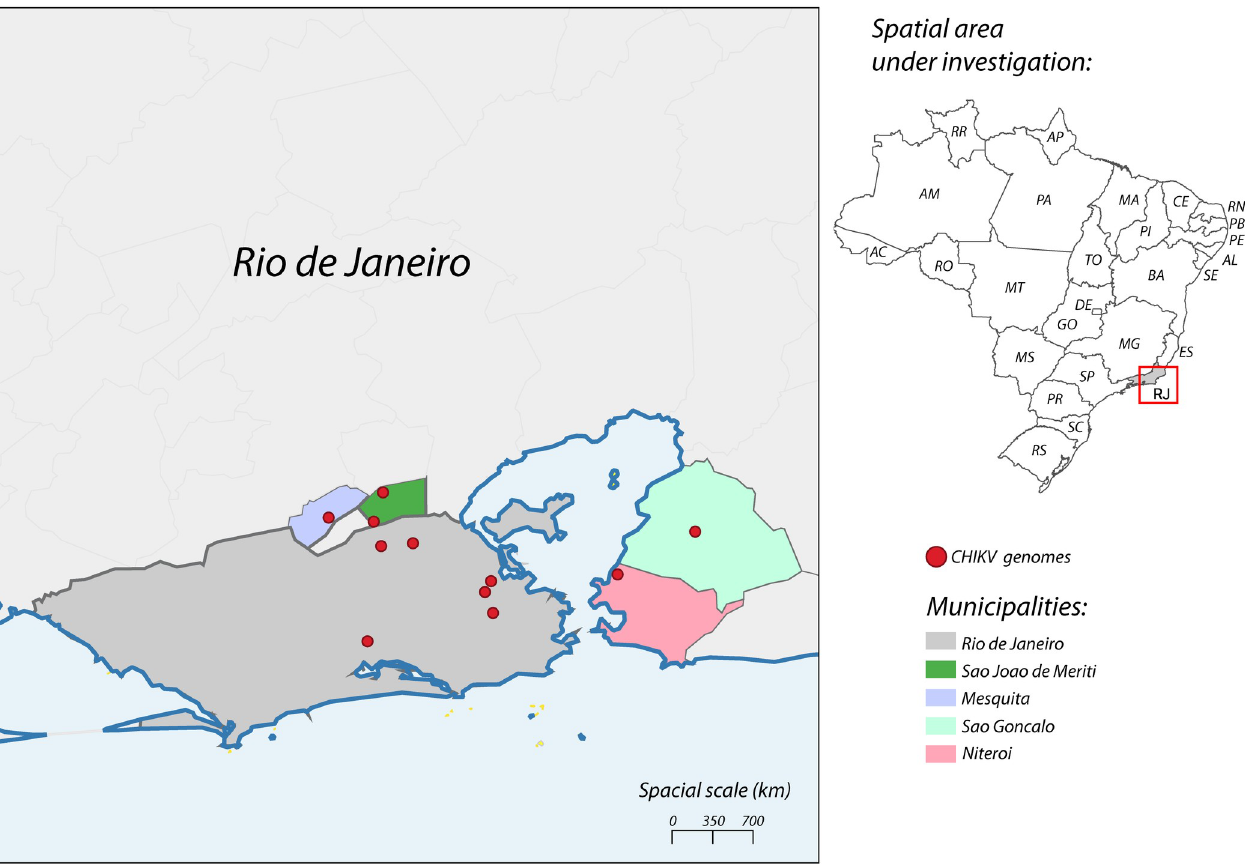
Fig 2. Map of the state of Rio de Janeiro. The state of Rio de Janeiro is located in south-eastern region of Brazil and its municipalities, where samples from this study were collected, are coloured in the map (see legend). Red circles indicate sampling locations of the isolates generated in this study. Map was generated by QGIS v3